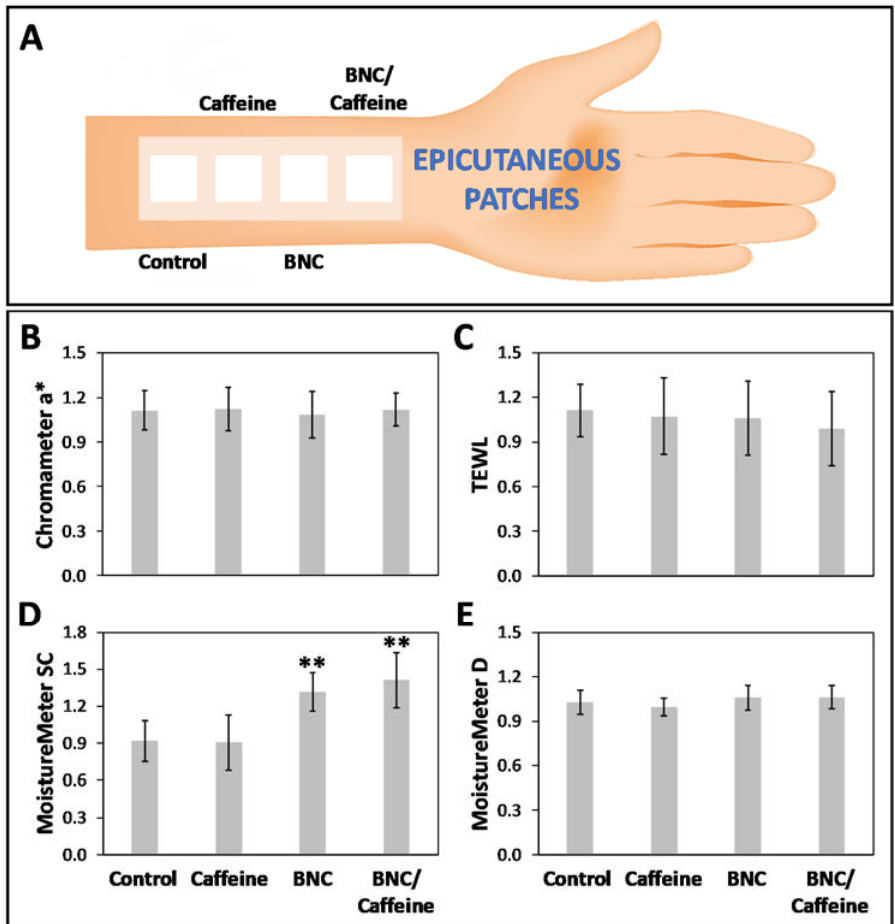
Figure 7. Cutaneous compatibility data obtained with 20 human volunteers (male and female): ( A ) erythema (skin irritation), ( B ) skin barrier function, ( C ) stratum corneum hydration, and ( D ) deep skin hydration; all values are the means and the error bars represent the standard deviation; the double asterisk (**) denotes statistically significant differences to the negative control (i.e., distilled water) ( p < 0.05).